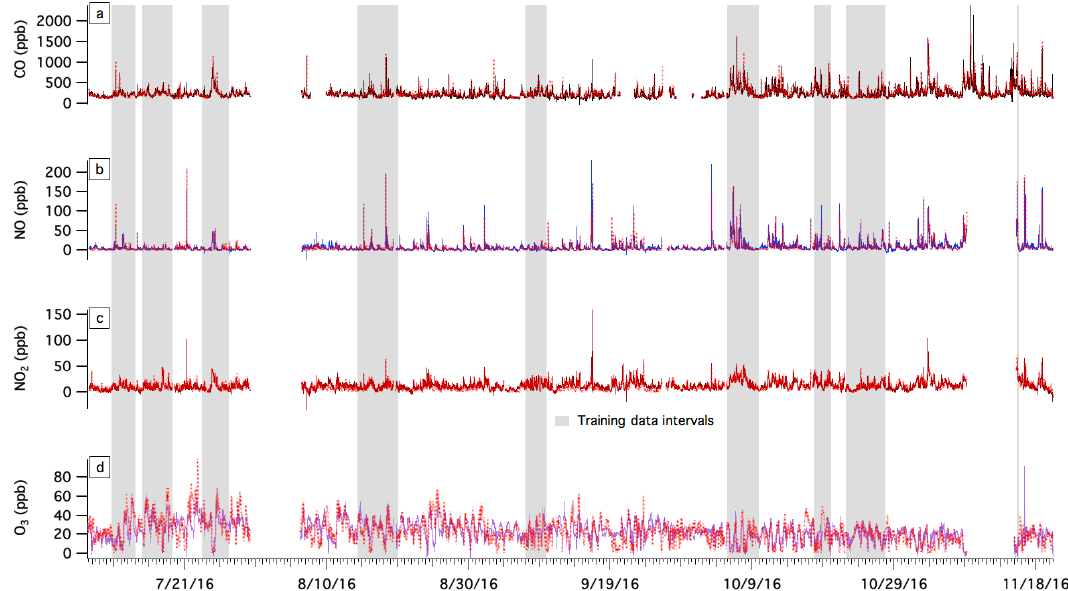
Figure 5. Time series of 5min averages of the model output (sensor) and reference gas concentrations. Grey shaded areas indicate time periods over which the model was trained. A unique set of input parameters was used to train the HDMR model for each of the different electrochemical cells. Approximately 25% of the data were used for training and the remaining 75% was used to test the models. Table 3. Performance metrics for model output versus reference measurements for test data (5min average temporal resolution).